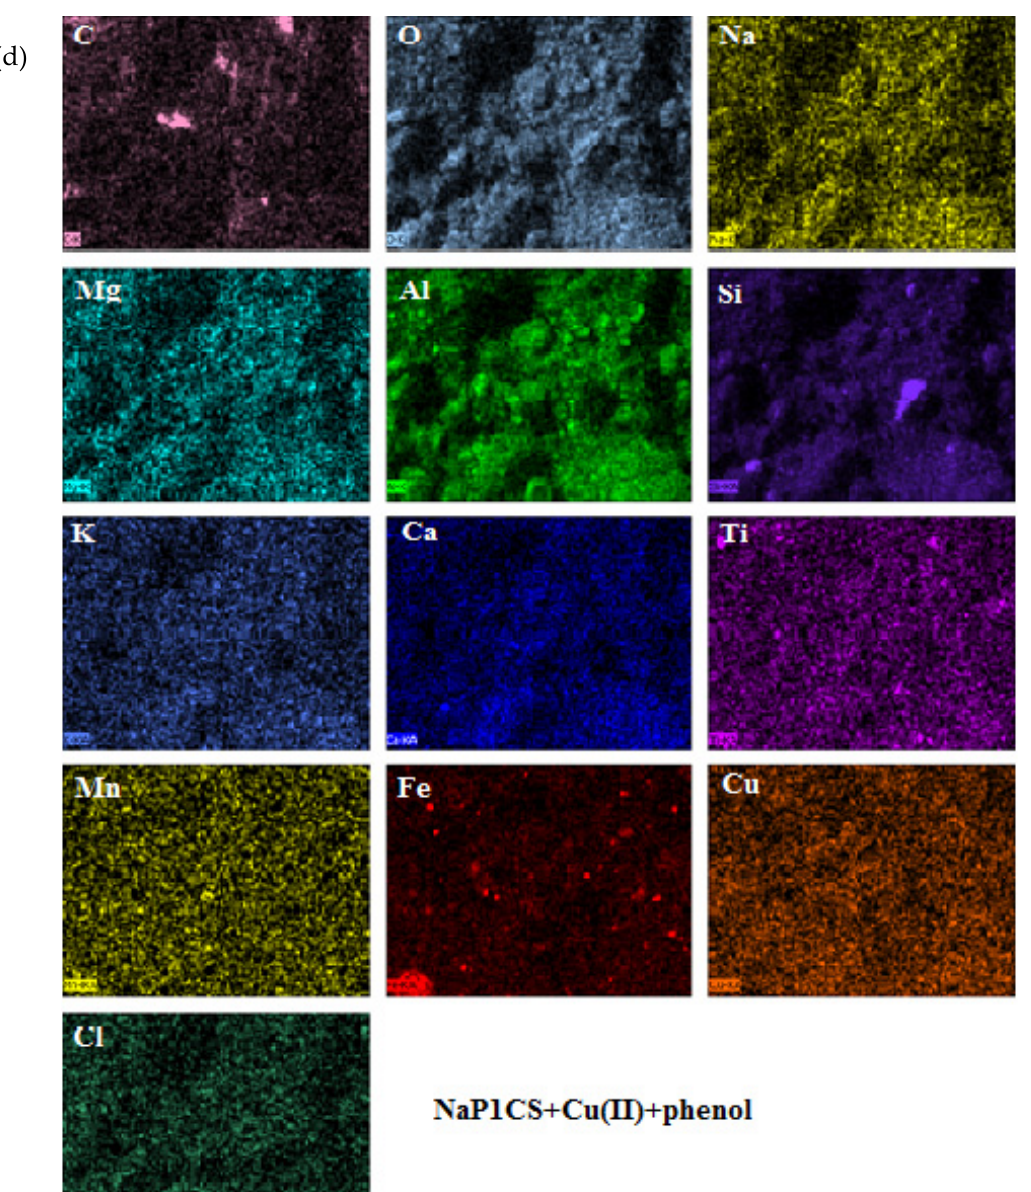
Figure 5. SEM–EDS analysis of ( a ) NaP1 and ( b ) NaP1CS after sorption of Cu(II) and phenol with the corresponding X-ray maps of C, O, Na, Mg, Al, Si, K, Fe, Ti, Mn, Cu, Ca, P, and S on ( c ) NaP1, and ( d ) NaP1CS (magnification: 1000×).